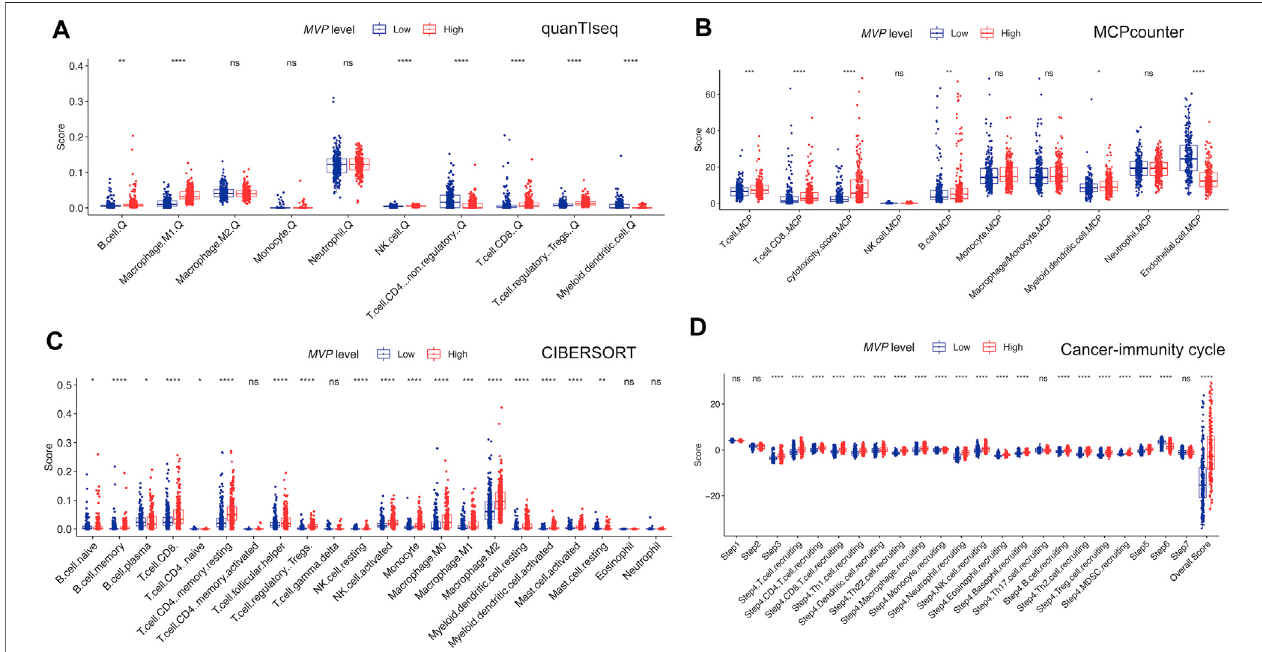
FIGURE 7 | Pro fi les of immune cell in fi ltration in MVPhigh and MVPlow PTC from TCGA dataset. Compare the in fi ltrating immunocyte scores calculated by (A) quanTIseq, (B) MCP-counter, and (C) CIBERSORT in MVP high and MVP low groups. (D) Compare each step of activity of cancer-immunity cycle between MVP high and MVP low groups. * p < 0.05, ** p < 0.01, *** p < 0.001, **** p <